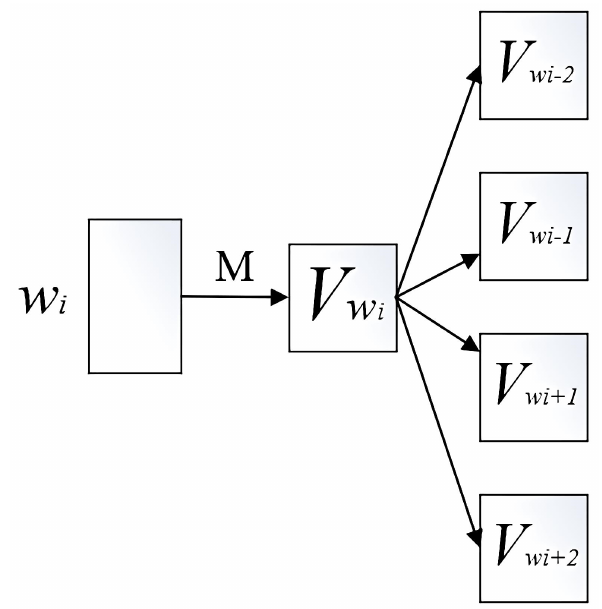
Figure 5. Skip − gram model